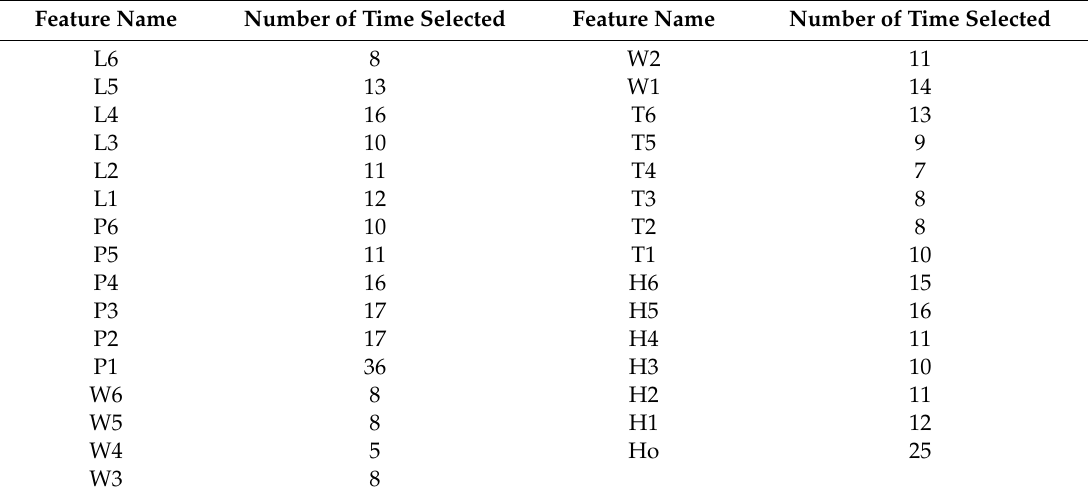
Table 2. Number of times a feature is selected